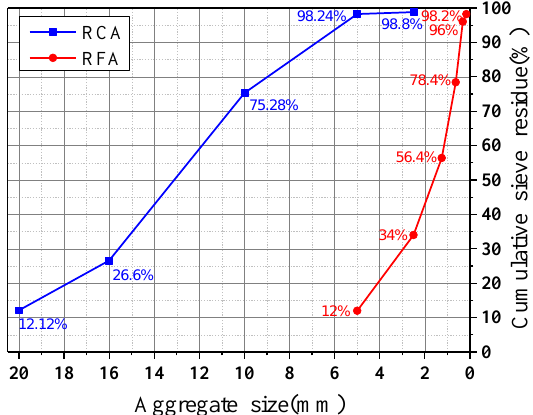
Figure 2. Aggregate sample. ( a ) NCAs; ( b ) NFAs; ( c ) RCAs; ( d ) RFAs.